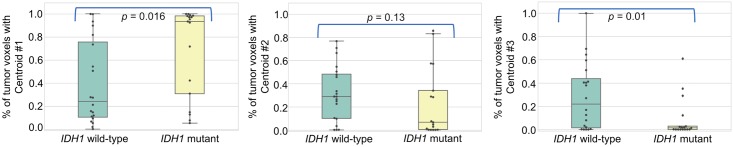
Association with IDH1 mutation status.Boxplots with percentage of tumor voxels with centroids #1, #2 and #3 (from left to right) according to the IDH1 mutation status.